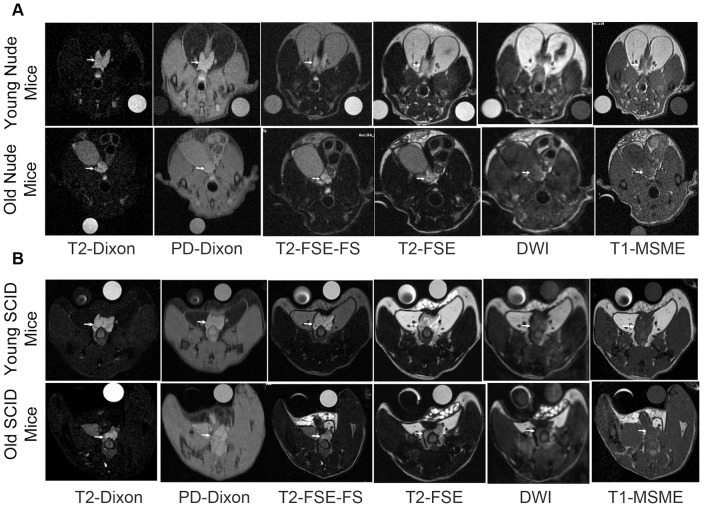
Representative MR images of the prostate gland of nude (4.7T, A), SCID (7T, B) young (top) and old (bottom) mice with different MR sequences.Arrow indicates the prostate gland.